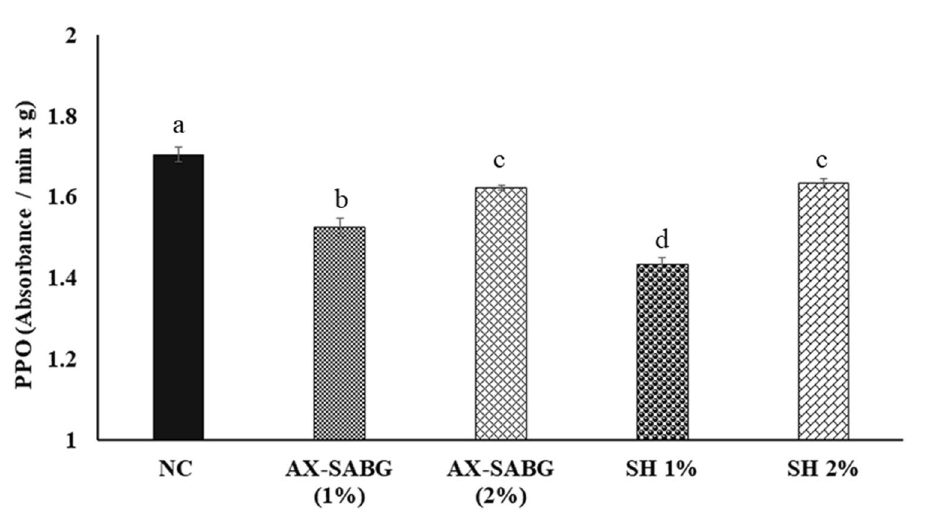
Figure 4. Change in polyphenol oxidase activity of peach during storage ( NC uncoated, AX‑SABG arabinoxylan-β-d-glucan stearic acid ester, SH shellac). Data were analysed using ANOVA followed by Tukey’s multiple comparisons tests. The letters compare changes between the treatments. Different letters indicate significant differences at p <